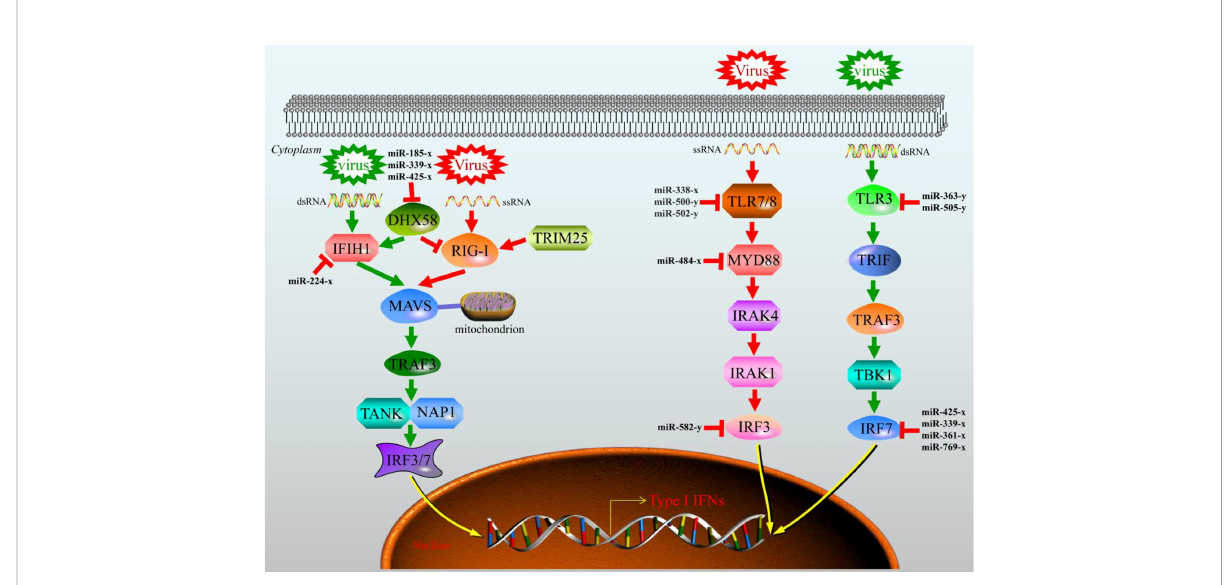
FIGURE 4 RIG-I like receptor (RLR) and Toll-like receptor (TLR) signaling pathways interaction in signaling against